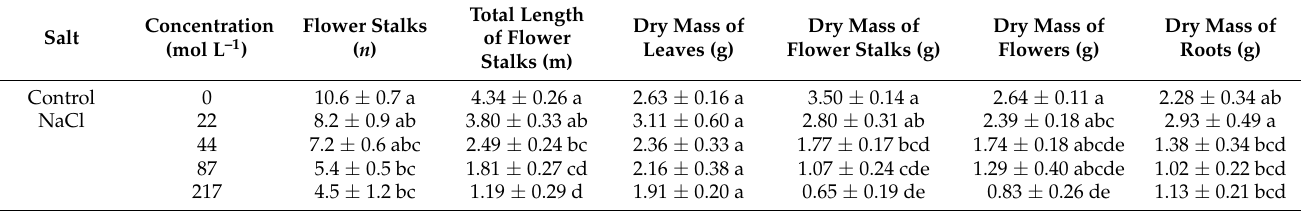
Figure 5. Effect of added NaCl, KCl and NaCl + KCl concentration in soil on total dry mass ( A ), dry mass of decayed leaves ( B ) and dry mass of living leaves ( C ) of Armeria maritima plants from